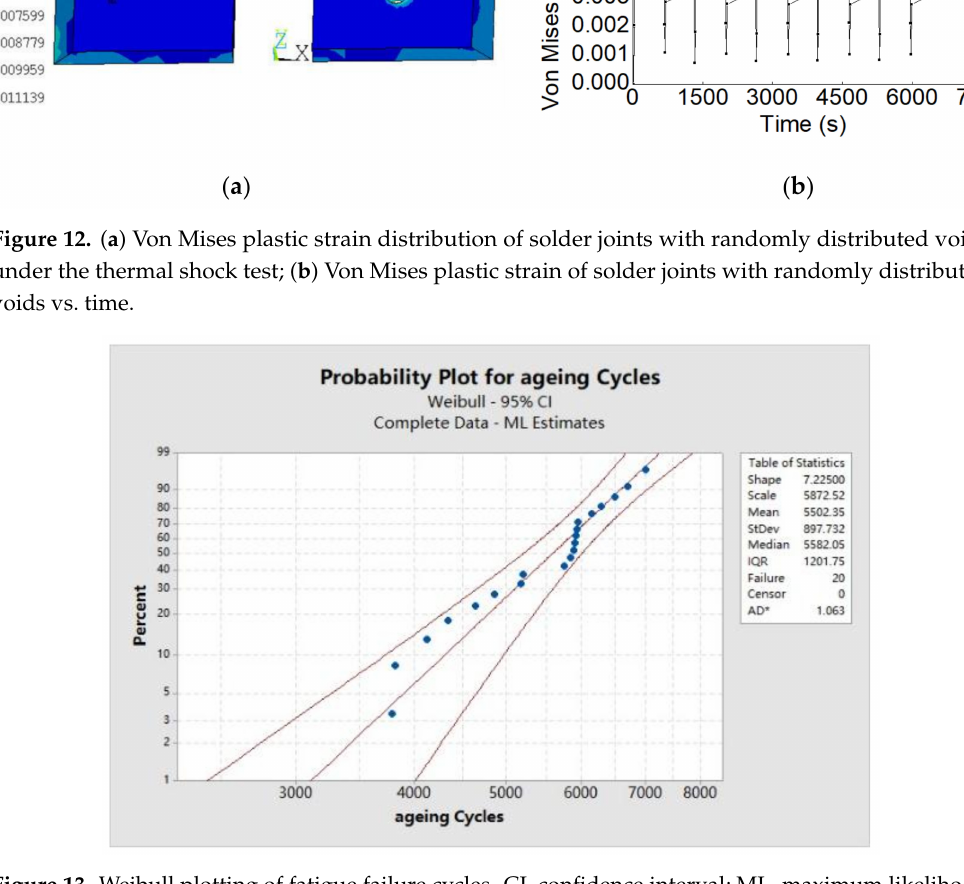
Figure 13. Weibull plotting of fatigue failure cycles. CI, confidence interval; ML, maximum likelihood; IQR, interquartile